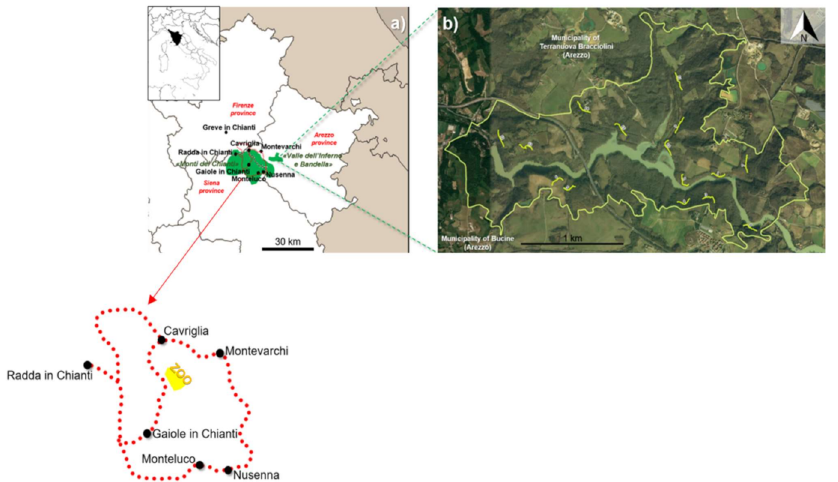
Figure 1. ( a ) Location of the study area (Central Italy, with green areas showing the two Special Areas of Conservation where our survey was conducted). The red dotted line indicated by the red arrow shows the 89 km road traveled each day (yellow polygon = ex Cavriglia zoo park); ( b ) the yellow segments show the 15 paths (200 m each) traveled by foot within the “Valle dell’Inferno and Bandella” Natural Reserve. The continuous yellow line shows the border of the Valle dell’Inferno reserve, where some individuals were observed in 2019 (see